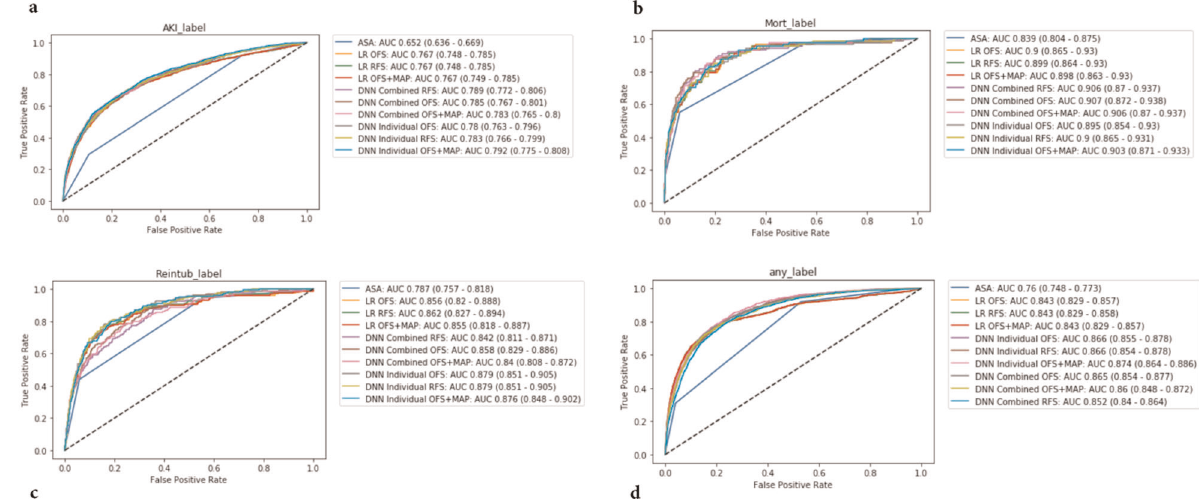
Fig. 2 ROC Curves for AKI, mortality, reintubation and any outcome. ROC Curves for AKI ( a ), mortality ( b ), reintubation ( c ) and any outcome ( d ). Receiver operator characteristic curves for acute kidney injury (AKI), reintubation, mortality, and any outcome for the test set ( N = 11,996) for the ASA score, logistic regression (LR) models, deep neural networks predicting individual outcomes (DNN individual), and deep neural networks predicting all three outcomes (DNN combined). Each model was also evaluated for each feature set combination of original feature set (OFS), OFS + the minimum MAP features (OFS + MAP), and reduced feature set (RFS). Note that for the LR and individual models, there is one model per outcome and the predicted outcome probabilities from each model is stacked to predict any outcome. For the combined models, there is one model for all three outcomes and those probabilities are stacked to predict any outcome. *It should be noted that AKI labels were only available for 4307 of the test patients, and so all AUCs re fl ect results for only those patients with AKI